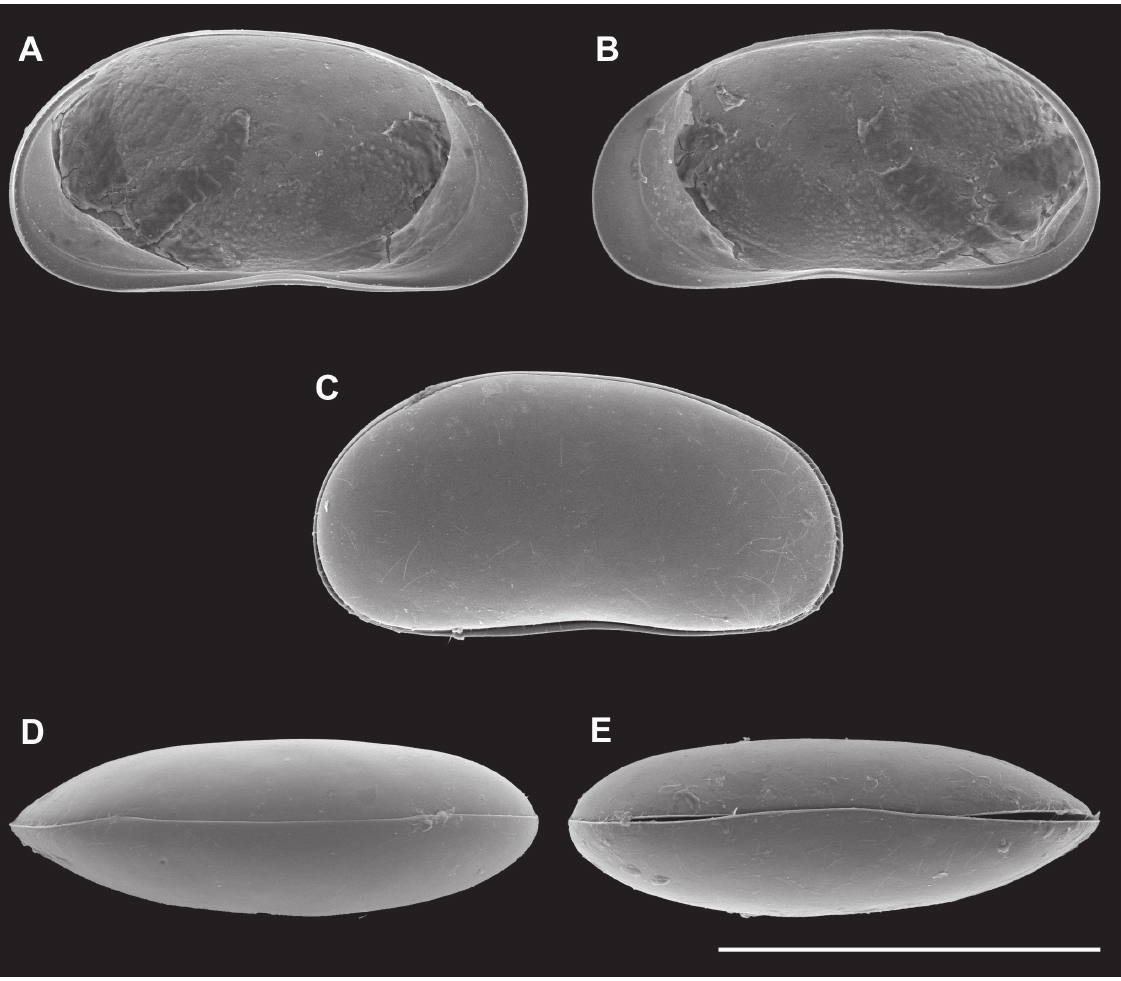
Fig. 8. Valves of Pseudocandona claudinae sp. nov. (♀). A . LV, internal view (MZUSP 32683). B . RV, internal view (MZUSP 32683). C . Cp, right lateral view (MZUSP 32684). D . Cp, dorsal view